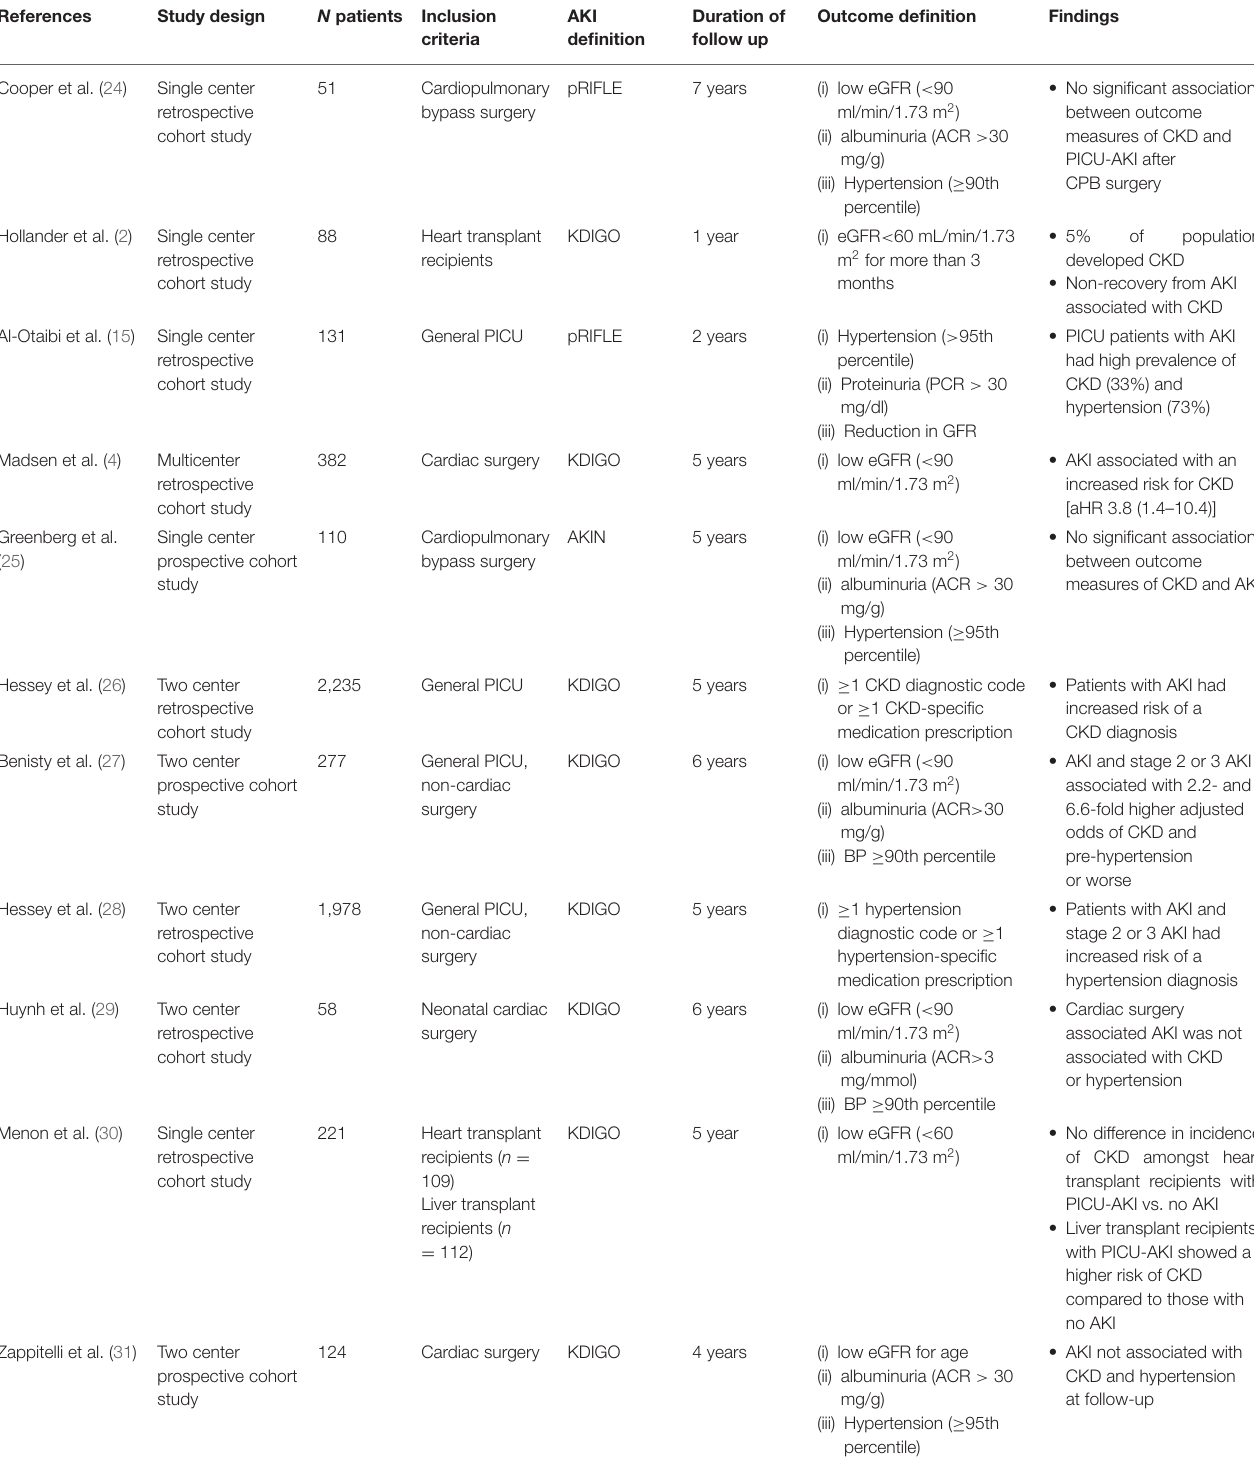
Key articles evaluating the association between PICU-AKI and long-term kidney outcomes including CKD, proteinuria, and hypertension published since 2015. This may not be an exhaustive list as a formal systematic review search was not performed. KDIGO, Kidney Disease: Improving Global Outcomes; pRIFLE, pediatric Risk, Injury, Failure, Loss, End stage renal disease.; AKIN, acute kidney injury network criteria; AKI, acute kidney injury; aHR, adjusted hazard ratio; PICU, pediatric intensive care unit; CKD, chronic kidney disease; SCr, serum creatinine; eGFR, estimated glomerular; CPB, cardiopulmonary bypass.